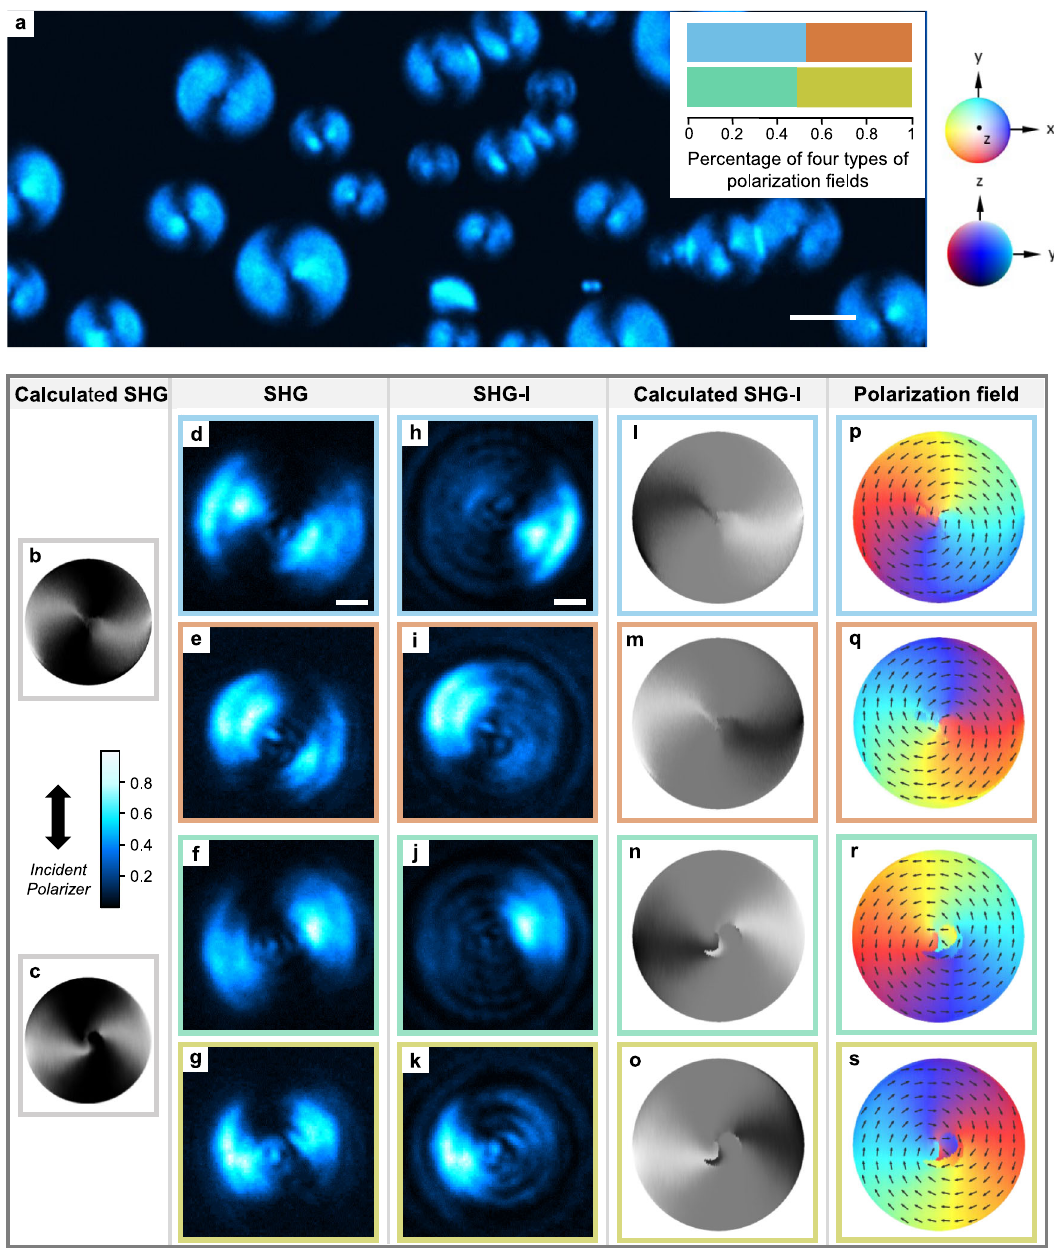
Fig. 4 | PolarizationtexturesprobedbySHGand SHG-Imicroscopy. a XY-cross- sectionalSHG-CPMimagesoftheN F droplets.Thepolarizationoftheincidentlaser is shown as the black double arrow. Scale bar, 10 μ m. The inset shows the statistic number counts of four types of polarization fi elds observed in the experiment. d – s Four types of the polarization fi elds P ( r ) are demonstrated in rectangles with blue, orange, green and yellow edges respectively. Experimental SHG microscopy ( d – g )andSHG-Imicroscopy( h – k )observationsof4typesofpolarizationtextures. In SHG microscopy observation, two types of polarization fi elds with the same chirality ( d – g ) are degenerate. In SHG-I microscopy observations ( h – k ), the